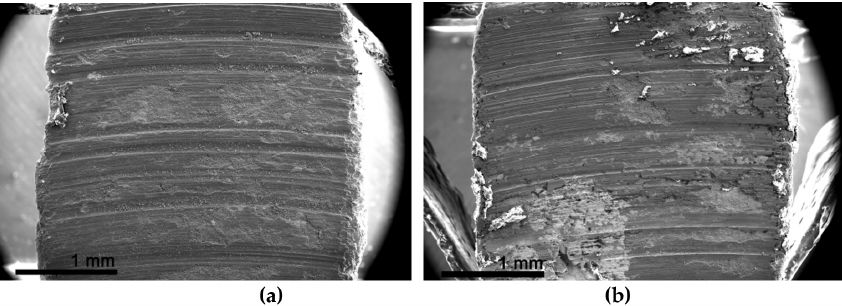
Figure 19. The worn surfaces of: ( a ) 0.6 g/layer sample; ( b ) 0.9 g/layer sample.